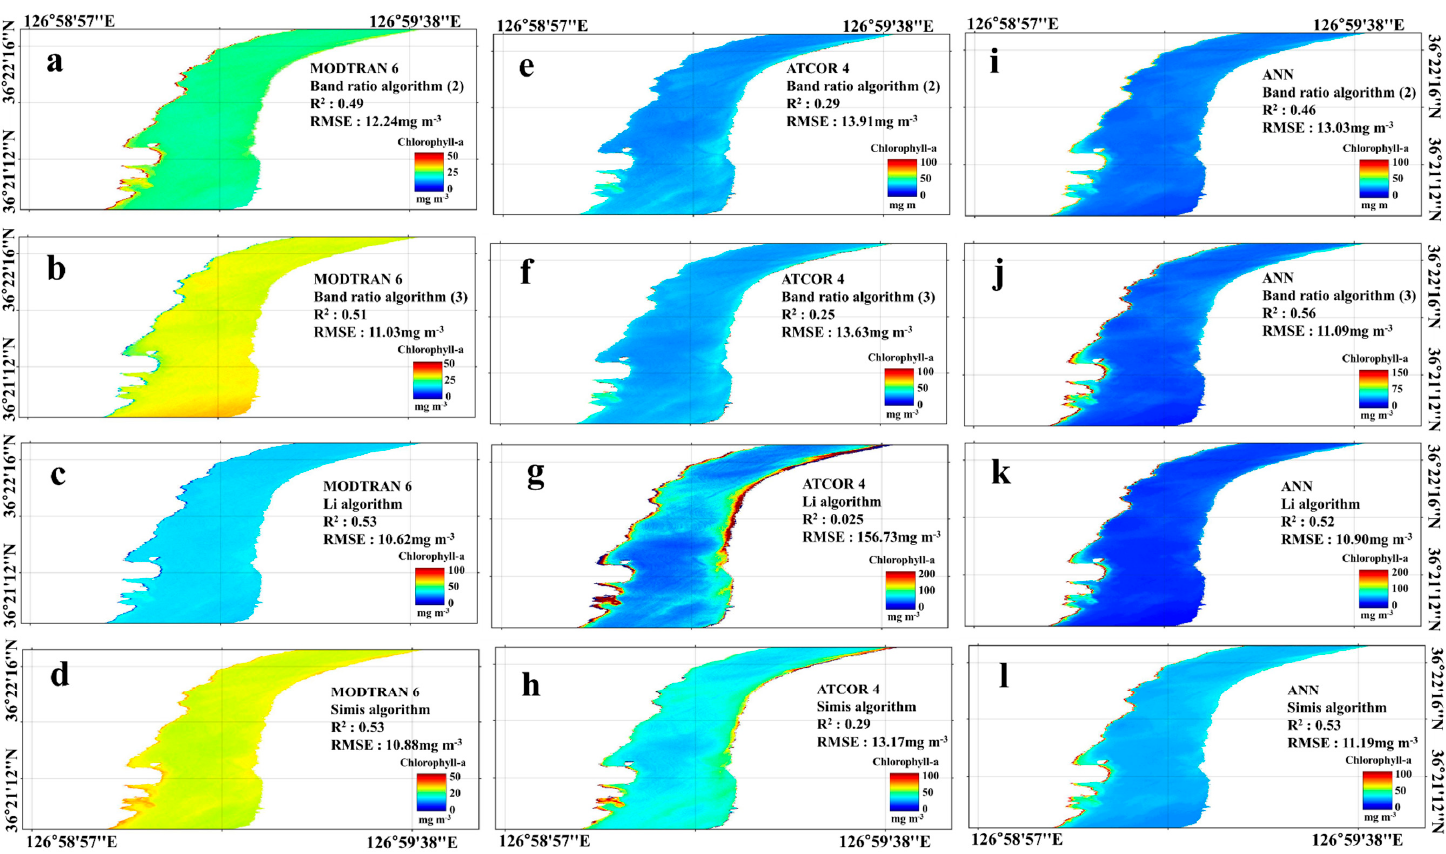
Figure 14. Chlorophyll - a (Chl-a) concentration images on 24 August 2016 in Section 2. Panels ( a – d ) show the Chl-a distribution driven by the MODTRAN 6 atmospheric correction. Panels ( e – h ) show the Chl-a distribution driven by the ATCOR 4 atmospheric correction. Panels ( i – l ) show the Chl-a distribution driven by the ANN atmospheric correction.